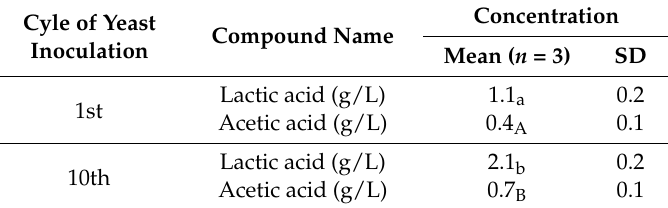
Table 6. Lactic acid and acetic acid content in mashes after the first and the tenth cycles of yeast inoculation (industrial